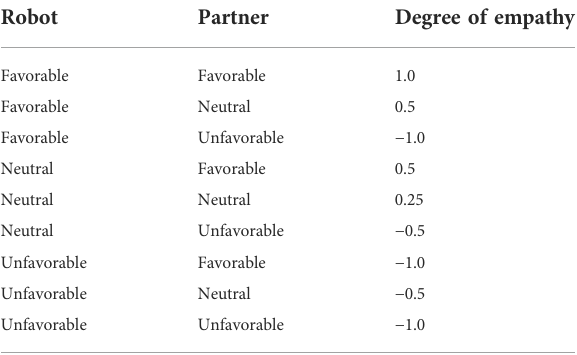
TABLE1Robot ’ sdegree ofempathyowingtotheattitudeoftherobot and partner. Robot